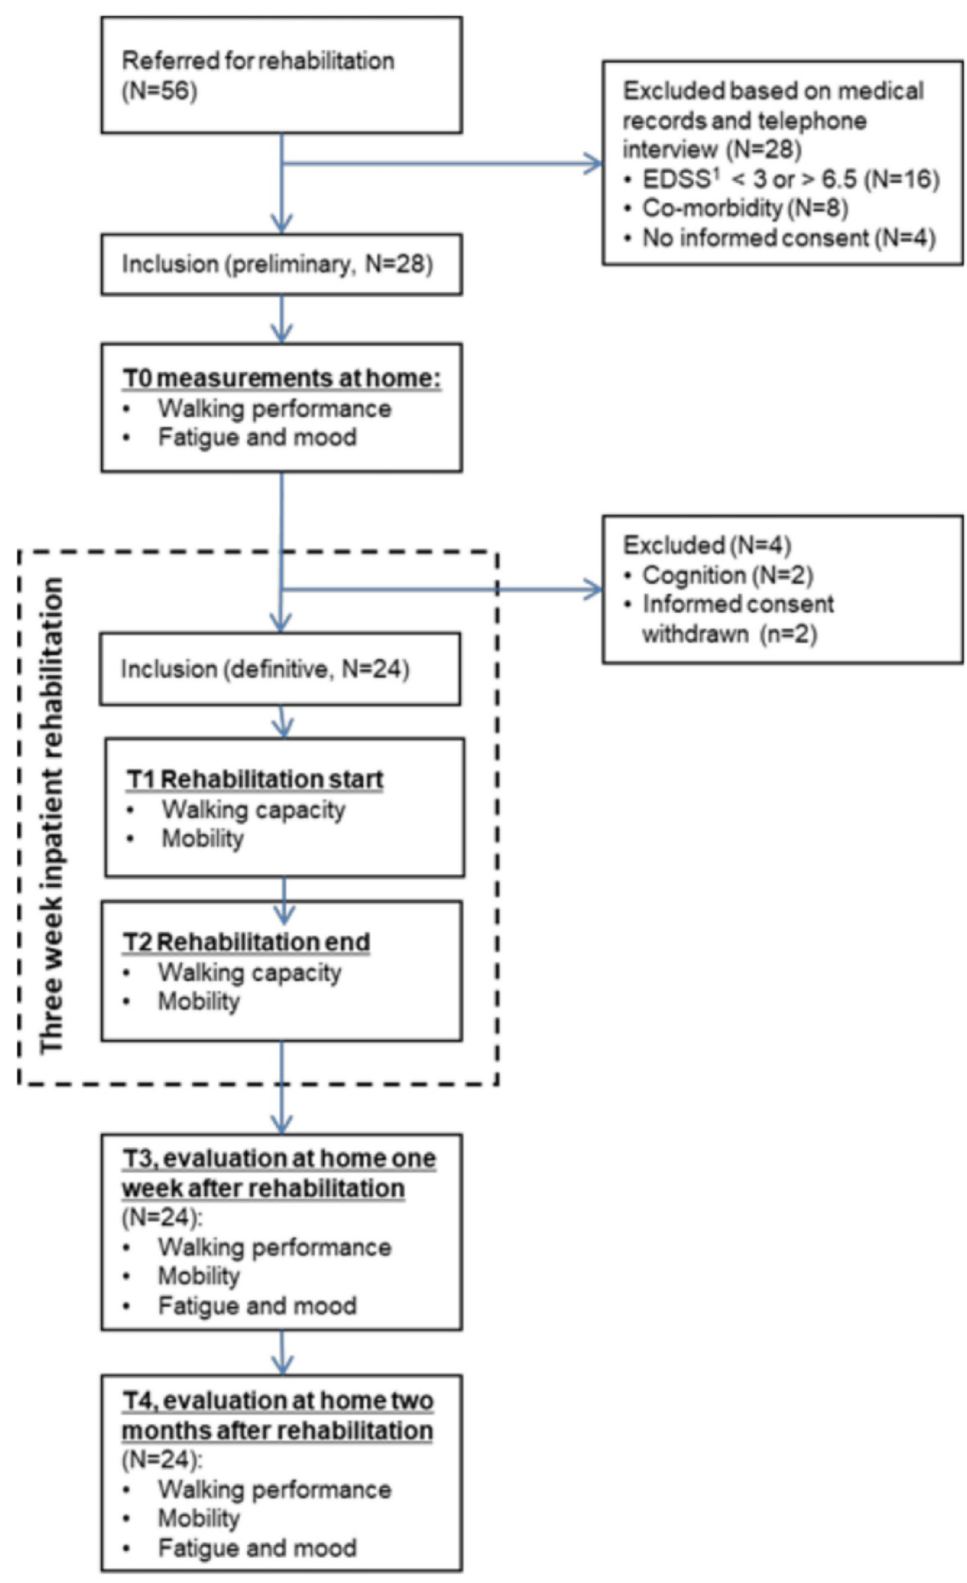
Fig 1. Study flow chart. 1 EDSS: Expanded Disability Status Scale. https://doi.org/10.1371/journal.pone.0274348.g001 PLOS ONE | https://doi.org/10.1371/journal.pone.0274348 September 19,